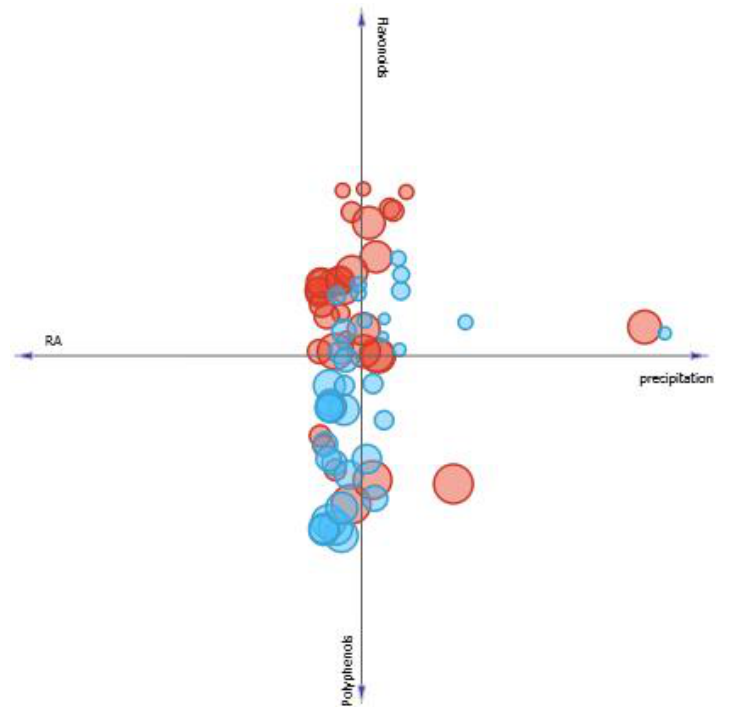
Figure 10. Linear projection correlating the content of phenolics, flavonoids, and rosmarinic acid of M. villosa (blue circles) and P. amboinicus (red circles) to precipitation. Circles size correspond to a greater or lesser SPF value found.